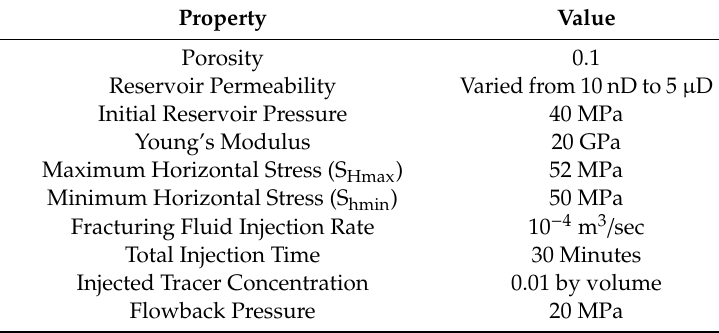
Table 1. Reservoir and geomechanical properties for tracer flowback simulations.